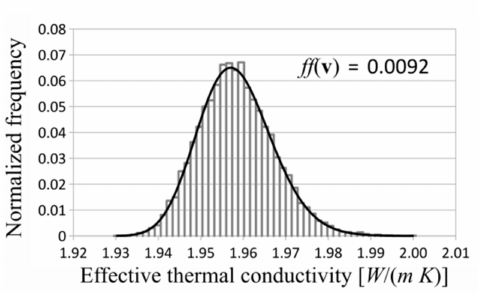
Figure 8. Histogram and gamma